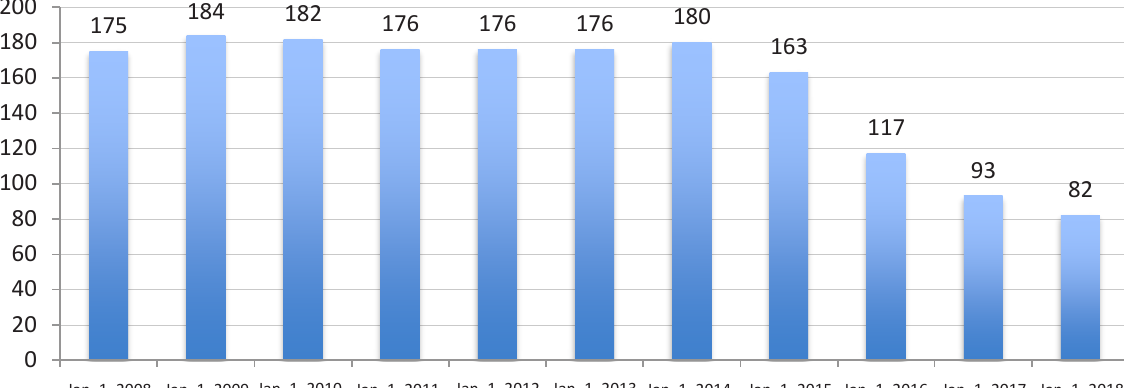
Figure 1. Dynamics of number of banks in Ukraine,